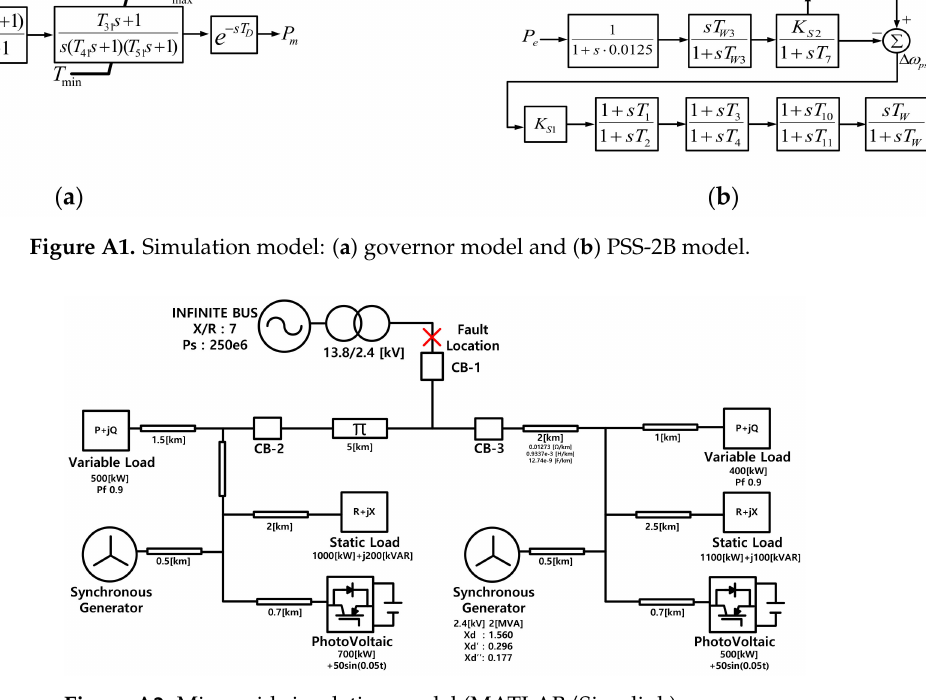
Figure A2. Microgrid simulation model